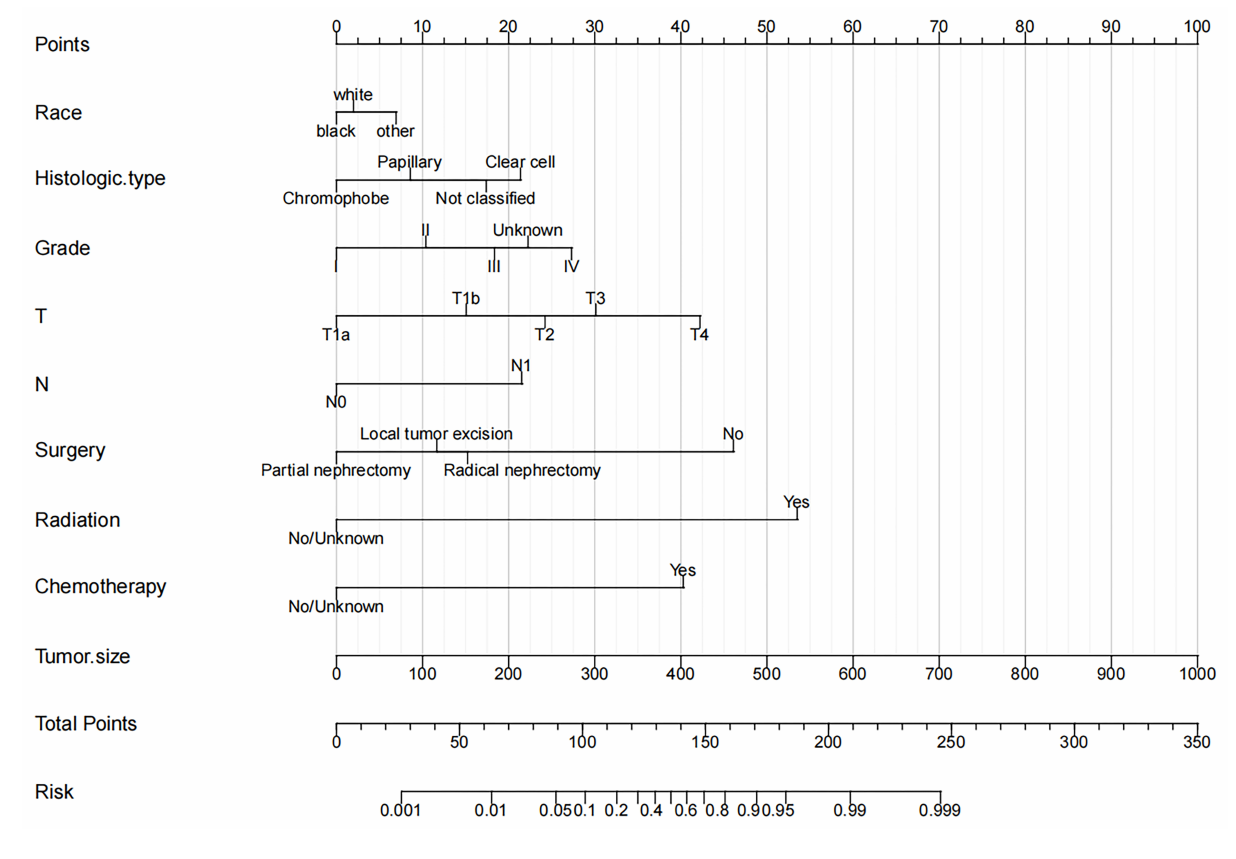
FIGURE 2 | Nomogram for distant metastasis of elderly patients with RCC.